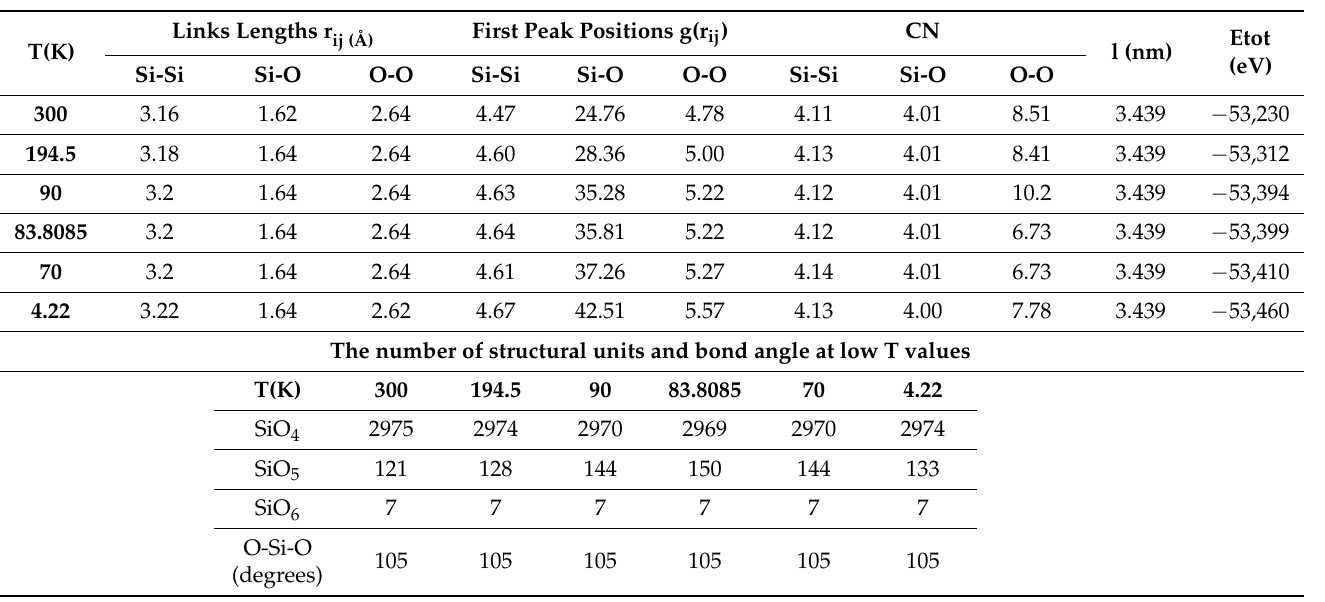
Table 5. The structural characteristic quantity of bulk SiO 2 at low T